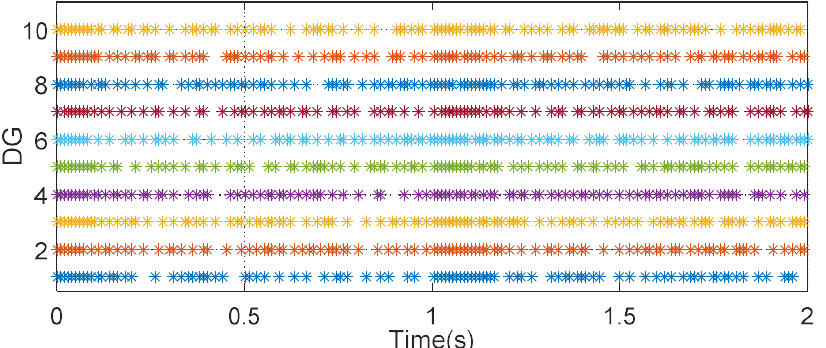
Figure 18. Triggering instant with ETCP under power generation fluctuation.